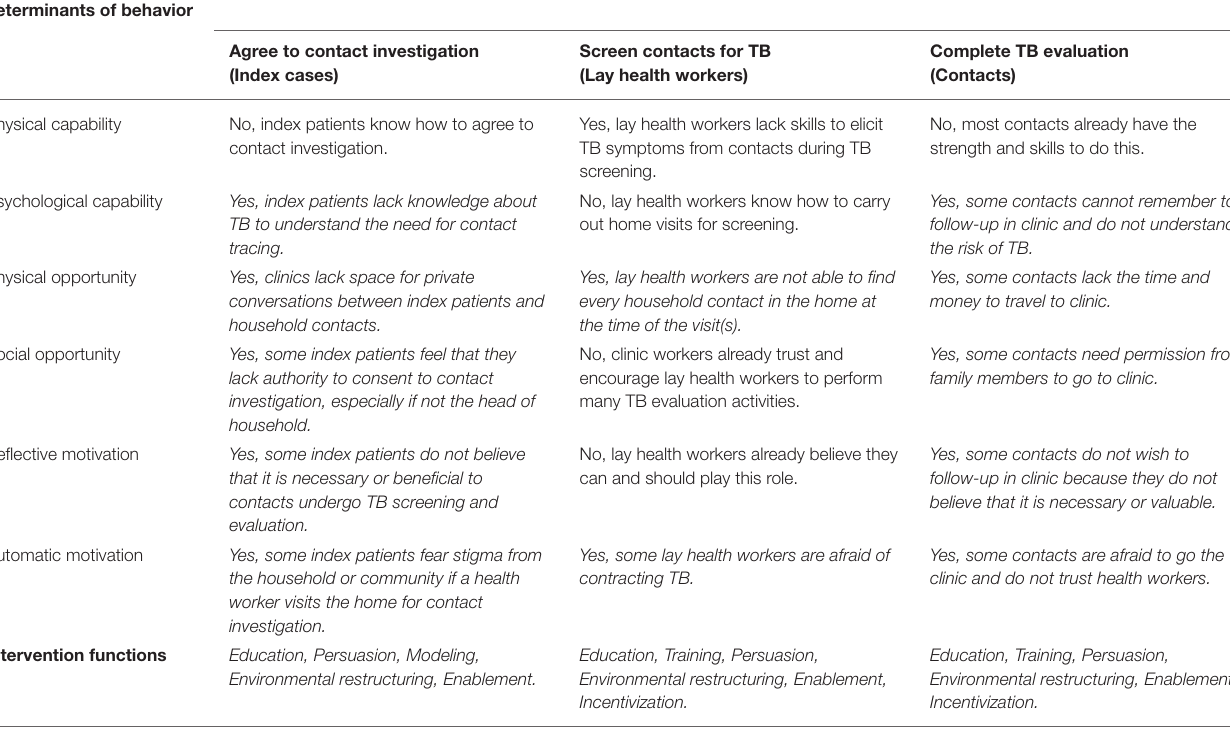
TABLE 2 | Behavioral determinants influencing adoption of three core behaviors of household TB contact investigation, and possible intervention functions specified by the behavior change wheel framework. COM-B determinants of